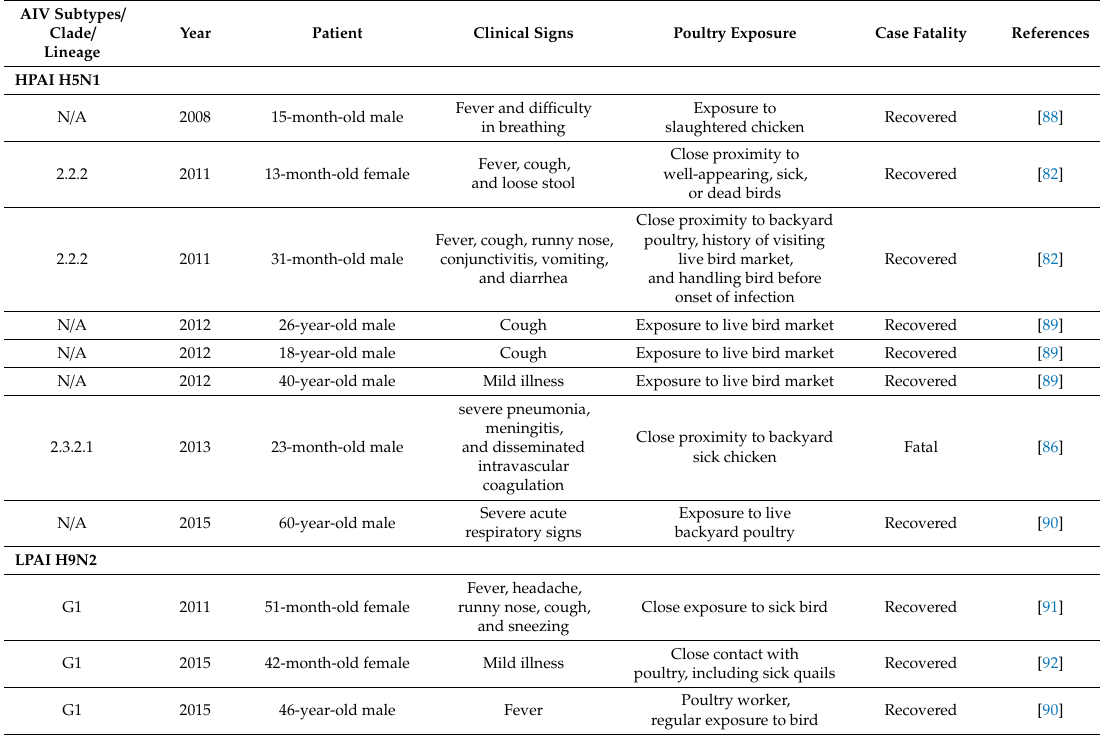
Table 2. Laboratory-confirmed human cases of high pathogenicity avian influenza (HPAI) H5N1